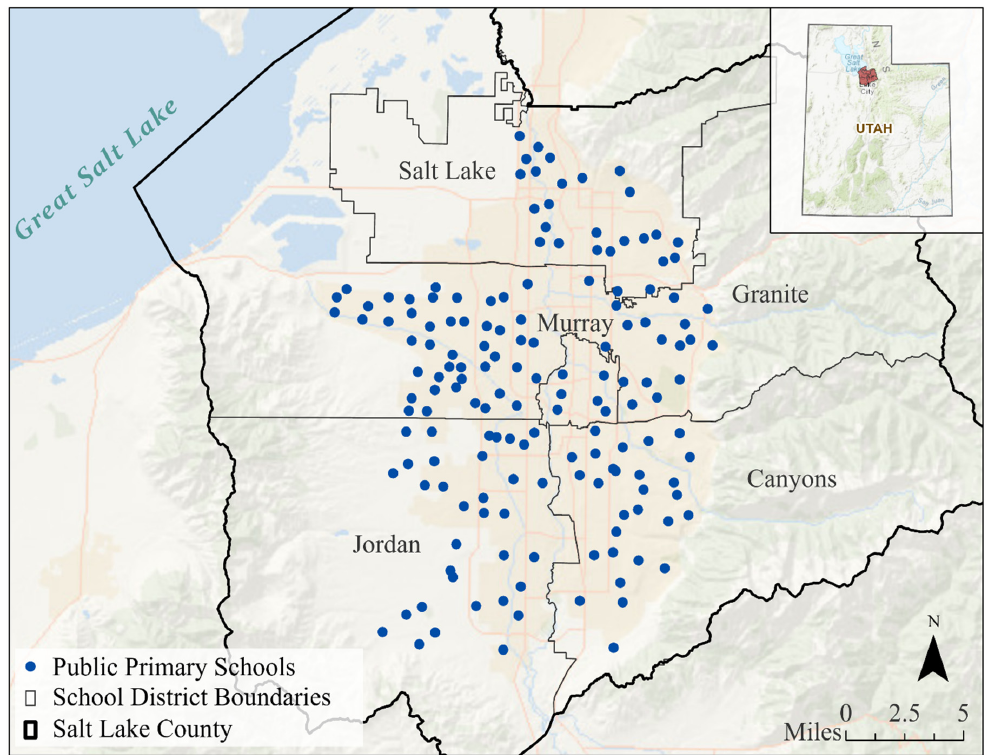
Figure 1. Salt Lake County case study area map showing the locations of Salt Lake County public primary schools ( n = 156) and school districts ( n = 5).